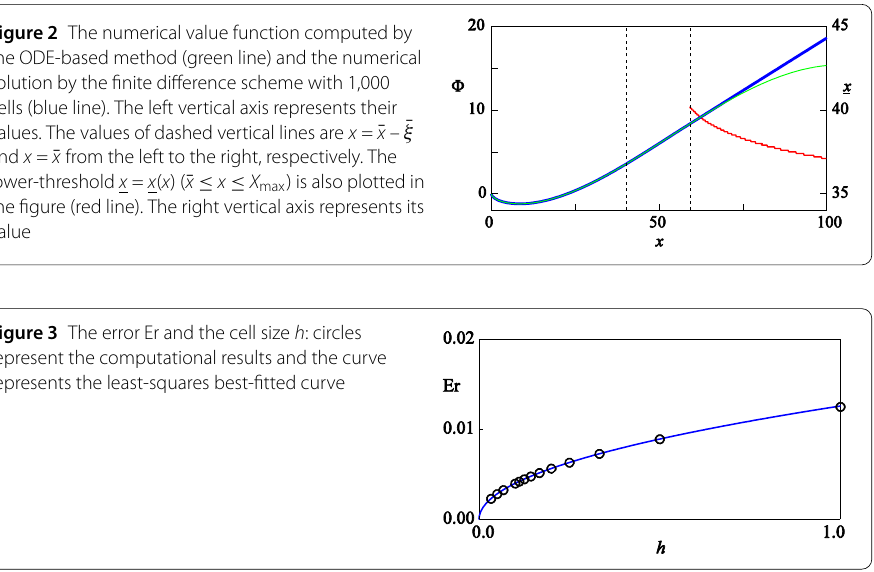
Figure 3 The error Er and the cell size h : circles represent the computational results and the curve represents the least-squares best-fitted